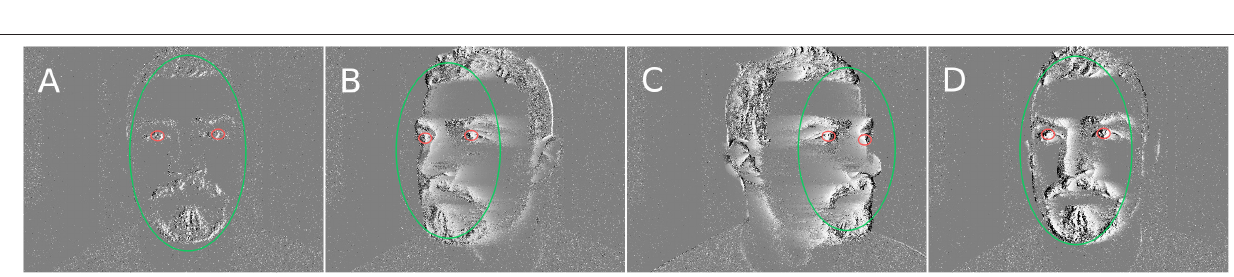
of the camera ranging from 25 cm to 1.50 m. A blink provides robust temporal signatures as its overall duration changes little from subject to